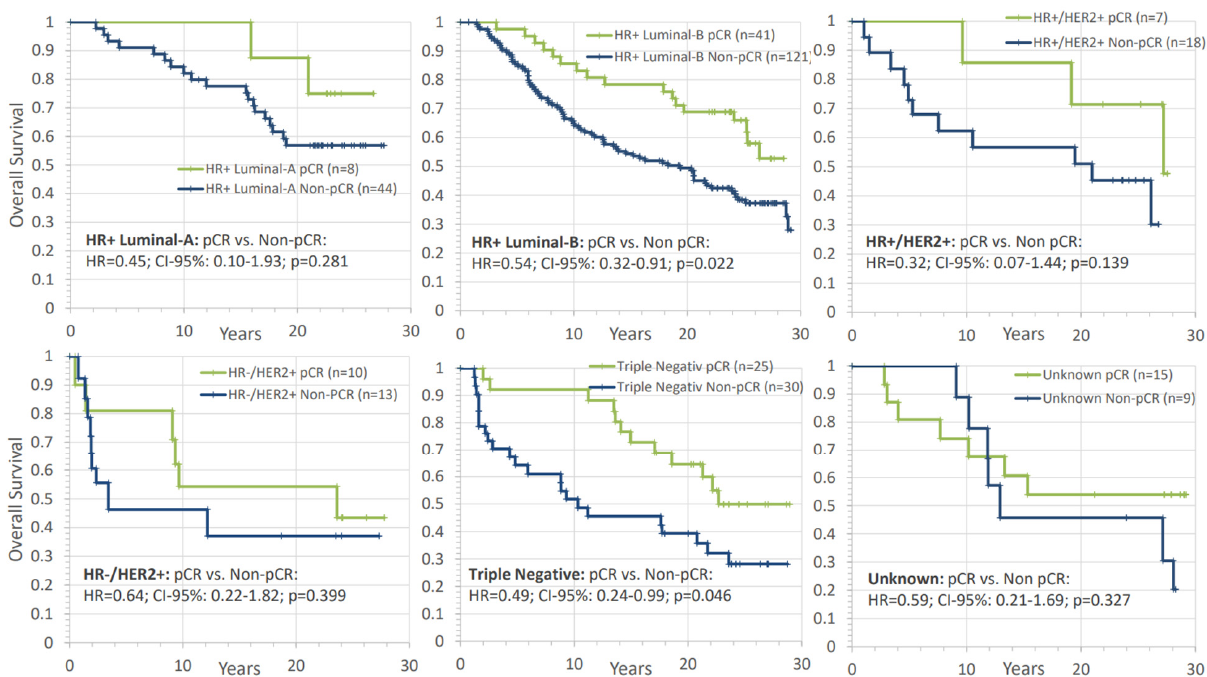
Figure 8. Analysis of the impact of pathological complete response (pCR) on overall survival in different breast cancer subtypes. The comparisons are presented with hazard ratios and their corresponding confidence intervals and p -values. HR+: hormone receptor positive, HER2+: human epithelial growth factor receptor 2, pCR: pathologic complete response, HR: hazard ratio, n: number of patients.